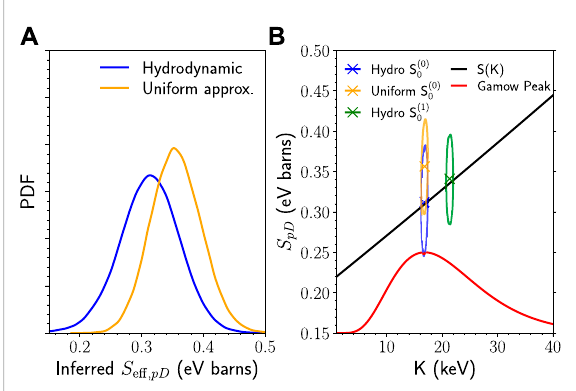
FIGURE 4 (A) Plot showing the probability distribution function (PDF) of the inferred p (D, γ ) 3 He effective S-factor for two different sets of assumptions on plasma conditions. For the study: the burn- averaged and spectrally inferred temperatures were 5.40 and 5.65 keV, respectively, the temperature standard deviation was 1.62 keV and the p/D fuel fractions were 50/50. The associated uncertainties are given at the beginning of Section 3.2. (B) Plot showing the inferred and “ true ” [7] nuclear S-factors from the synthetic data study. The crosses denote the centroid of the PDF and they are surrounded by the 1 σ contour, all inferences exhibit ~ 18% error. The zeroth order estimates ( S ( 0 ) 0 ) assume S eff ≈ S ( K G ), while the fi rst order estimate ( S ( 1 ) 0 ) uses Eqs 20a – 20d. For reference, the Gamow peak is shown in red. The MCMC was performed with the Python library emcee [19], PDFs shown here use ~80,000 samples, see Table 1 for more